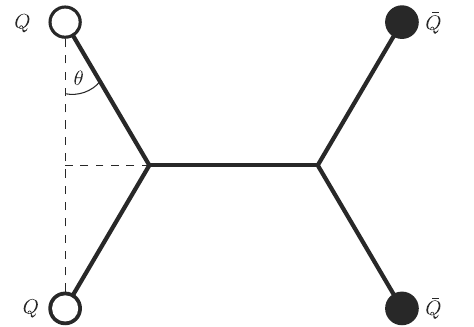
Fig. 3 The string profile for the tetraquark ( QQ )( ¯ Q ¯ Q ) made of two heavy quarks and two heavy